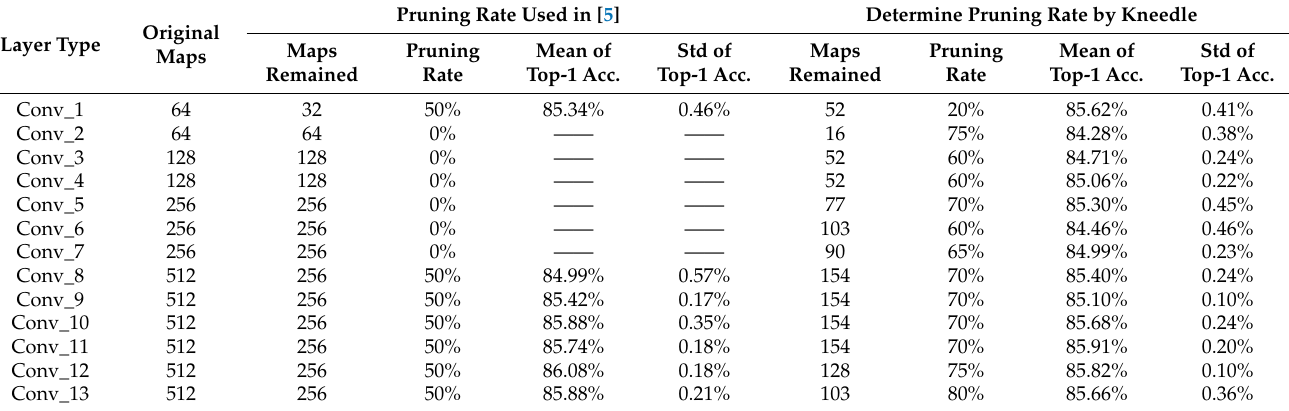
Table 1. Comparison of pruning